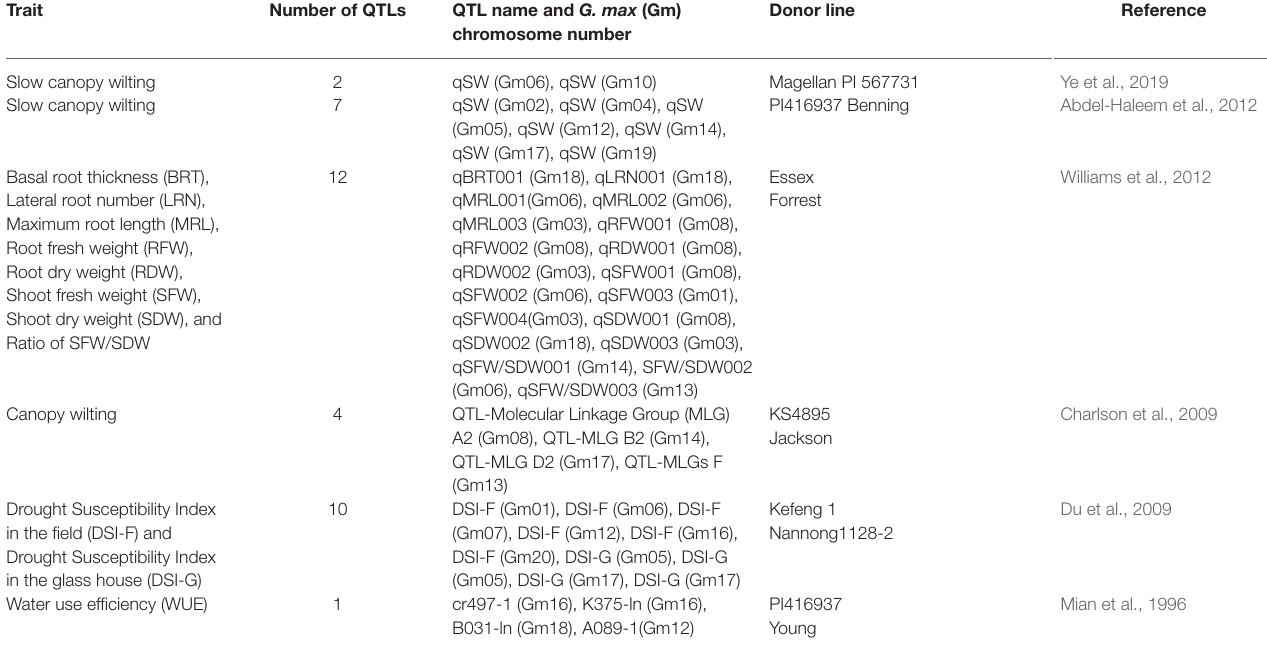
TABLE 1 | A summary of QTLs identified with soybean drought tolerance. Trait Number of QTLs QTL name and G. max (Gm) chromosome